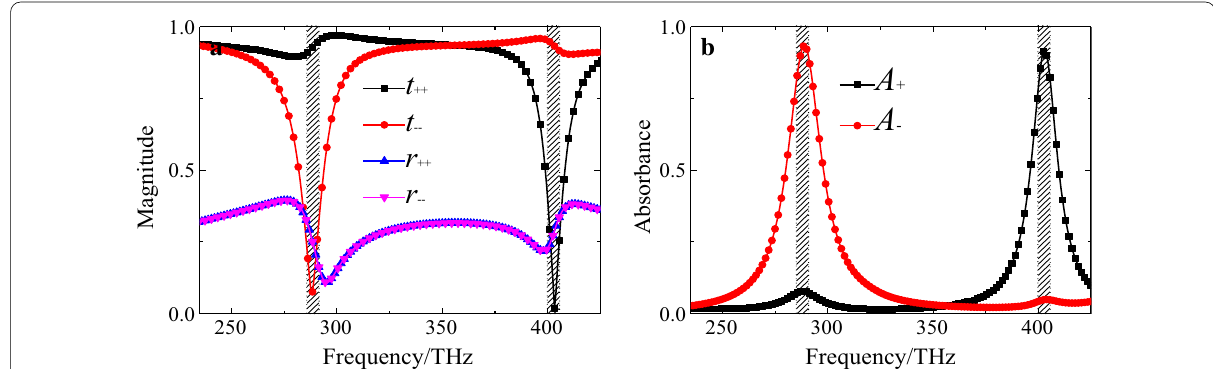
Fig. 2 a Simulated co-polarization transmission coefficients ( t the normal incident LCP and RCP lights, b the corresponding absorbance ( A